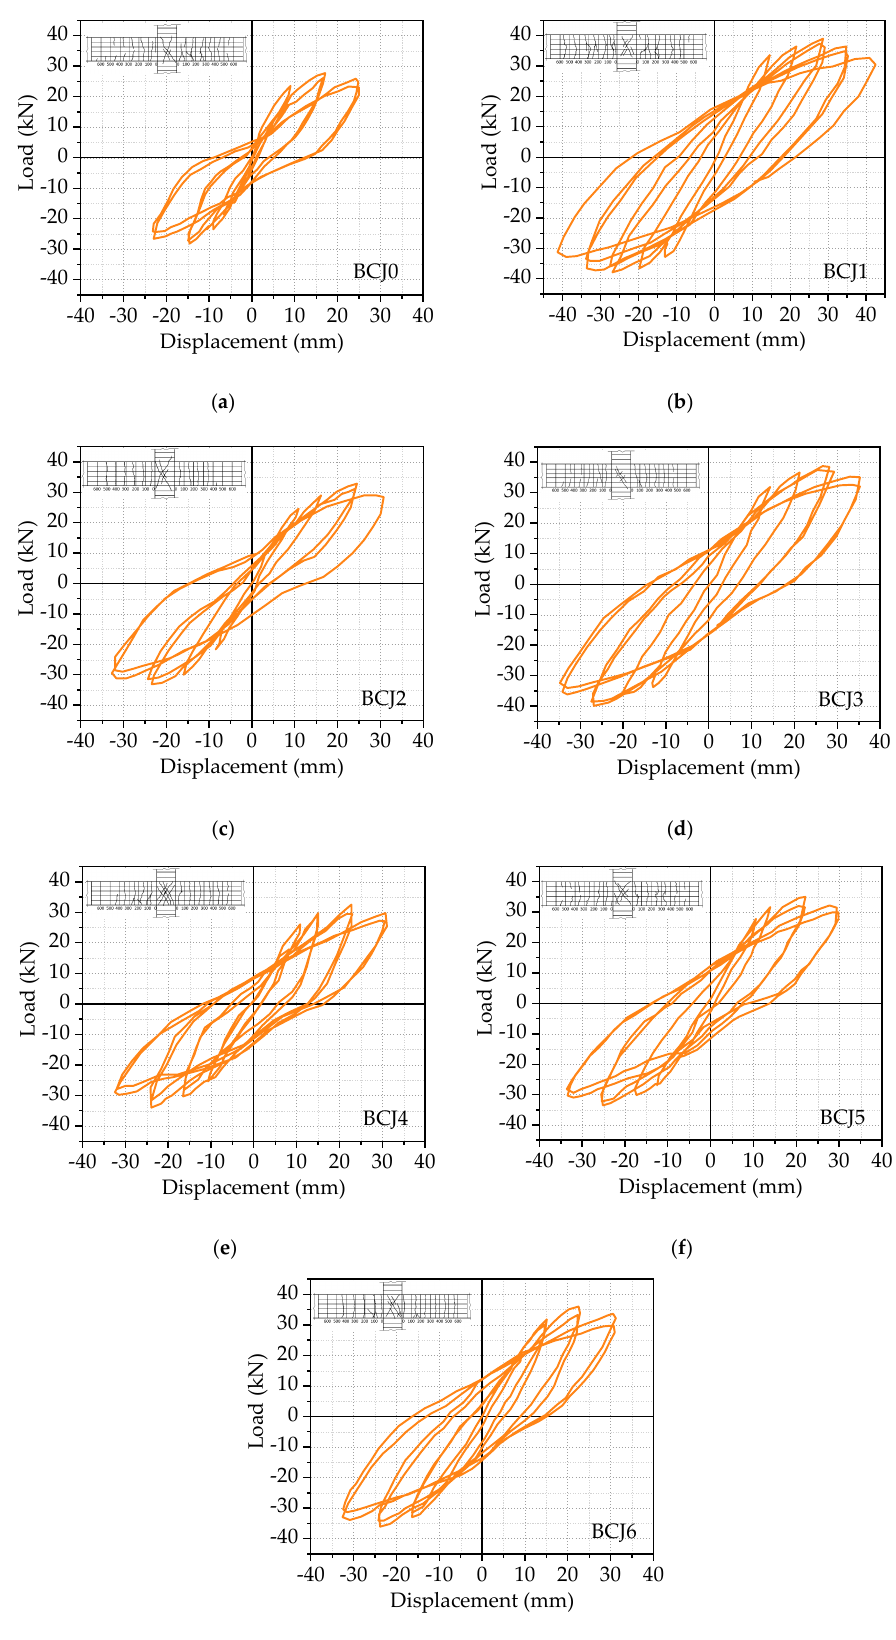
Figure 5. Final failure mode in the joint core area: ( a ) BFF; ( b ) JSF.